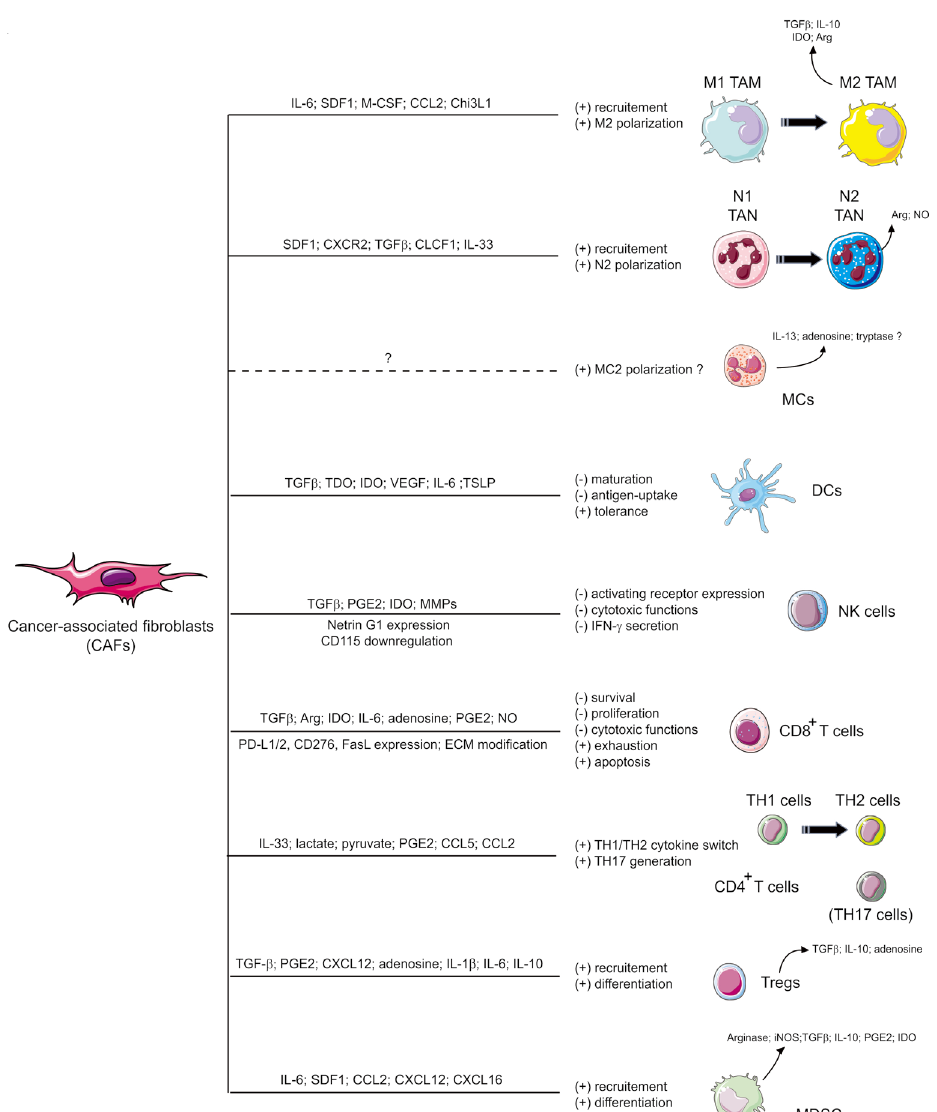
Figure 2. Schematic representation of CAFs-dependent immunosuppression. CAFs shape the tumor immune microenvironment and influence both the innate and adaptive anti-tumor immune response. CAFs are involved in the recruitment of innate immune cells, such as TAMs, and tumor-associated neutrophils (TANs), and promote their acquisition of an immunosuppressive phenotype (M2 and N2 respectively). CAFs also affect the cytotoxic function and cytokine production of natural killer (NK) cells and activate MCs with a potential immunosuppressive phenotype. CAFs also promote the recruitment and differentiation of myeloid-derived suppressor cells (MDSCs) and regulatory T cells (Tregs) and interfere with the maturation and function or dendritic cells (DCs). CAFs have also the ability to influence CD4 + Th lymphocytes, favoring tumor-promoting Th2 and Th17 responses, and reduce the activation, functions, and survival of CD8 + cytotoxic T cells. MCs: mast cells; CXCR2: C-X-C chemokine receptor 2; CLCF1: